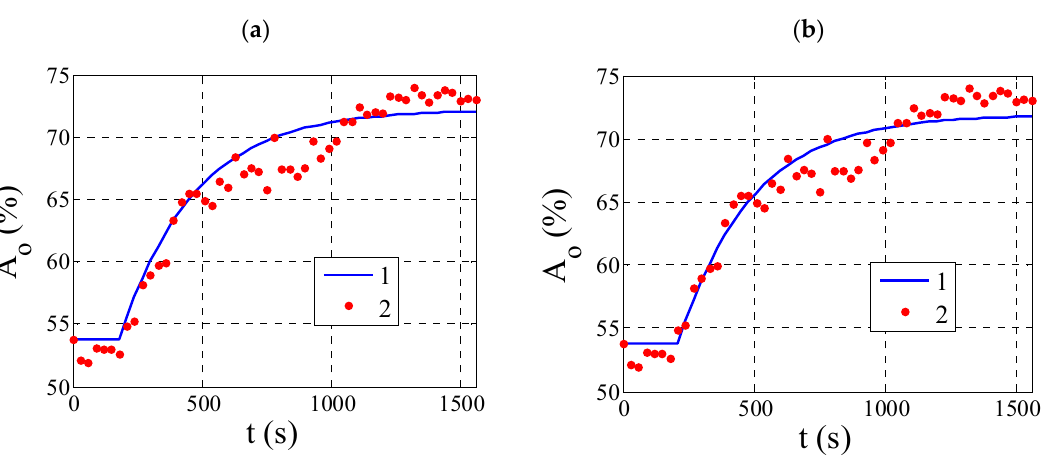
Figure 8. Results of the identification of the dynamic properties of the coal flotation process in terms of the response of the models to the step function (1) against empirical data (2), determined with the use of ( a ) the Kalman filter and ( b ) the least squares method.